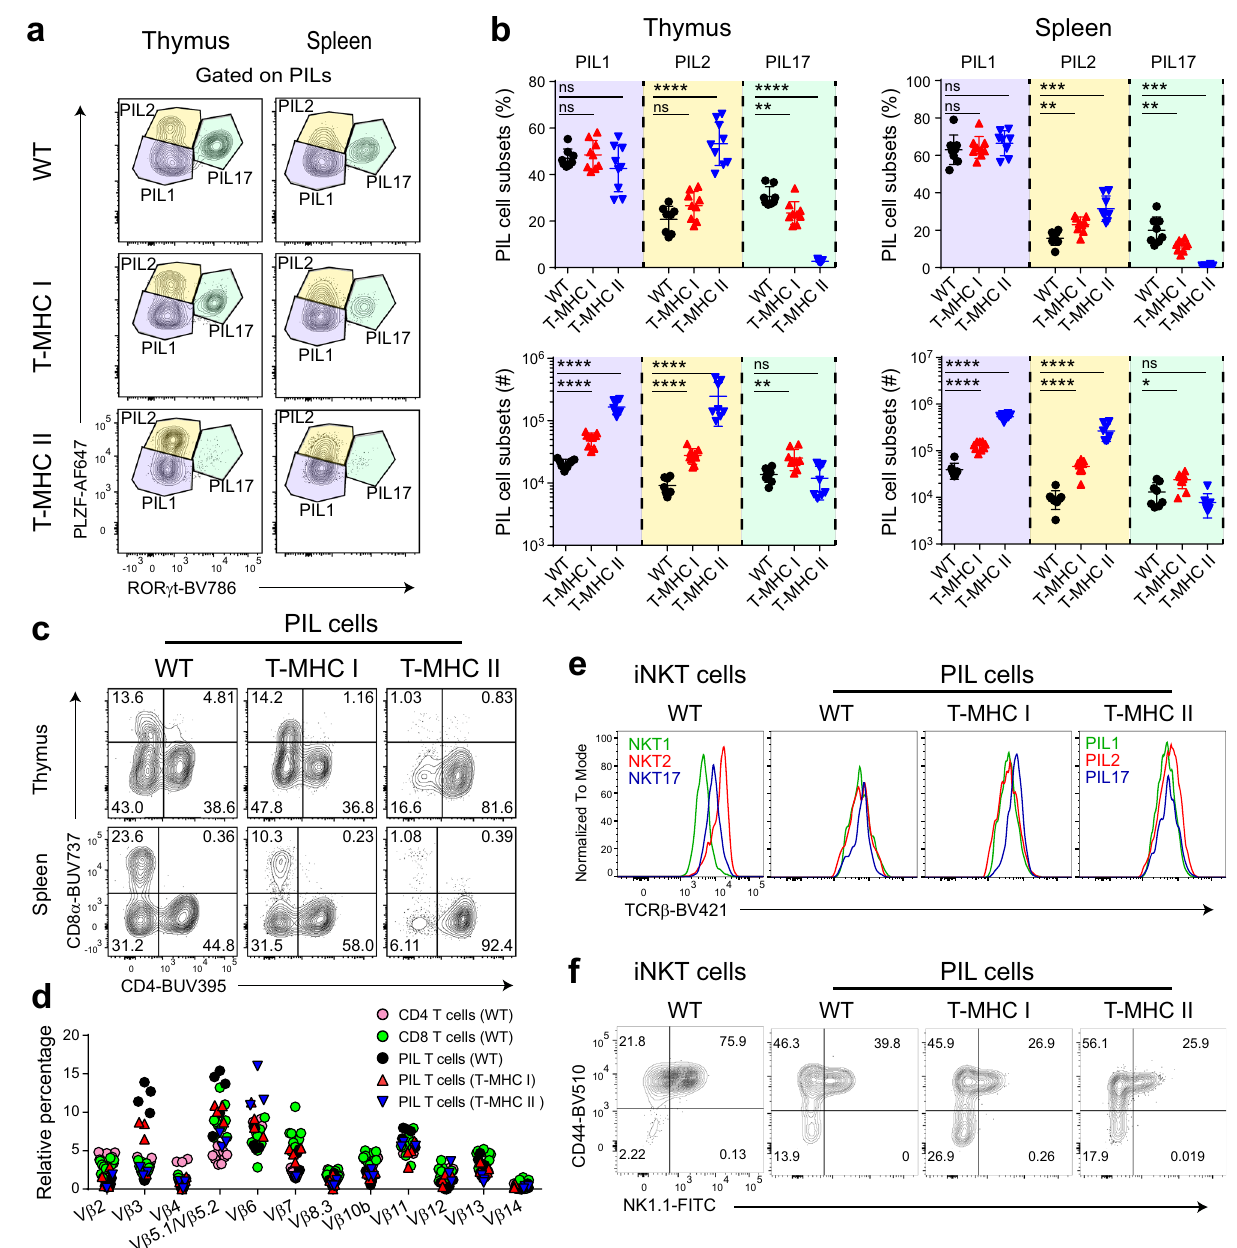
Fig. 4 Both MHC I and MHC II induced PIL T cells exist in three major subsets, similar to NKT cells. a Akin to iNKT cells, PIL T cells segregate into three subsets de fi ned by expression pattern of transcription factors PLZF and ROR γ t. Shown are representative fl ow cytometry plots comparing PIL T-cell subsets from WT, T-MHC I, and T-MHC II mice. b Comparisons of PIL T-cell subset frequencies (upper row) and numbers (lower row). c Representative fl ow cytometry plots of staining for CD4 and CD8 α on PIL cells from WT, T-MHC I, and T-MHC II mice. d Flow cytometry assessment of the TCR V β chain repertoire of thymic PIL T cells from WT, T-MHC I, and T-MHC II mice in comparison to conventional T cells. e Exemplary plots showing staining for TCR β on iNKT cell subsets compared to PIL T-cell subsets from WT, T-MHC I, and T-MHC II mice. All analyzed animals are F1 generation with BALB/c mice (further characterized in Fig. 6). f CD44 and NK1.1 expression pattern on (from left to right) iNKT, WT PIL, T-MHC I PIL, and T-MHC II PIL T cells. b Each point represents one animal: n = 8 animals per group (WT and T-MHC II groups) and n = 9 animals (T-MHC I group). Data are representative of seven in a – c and three in d – f independent experiments. Unpaired two-tailed Mann – Whitney test was performed in b ; ns, not signi fi cant ( p ≥ 0.05), * p <